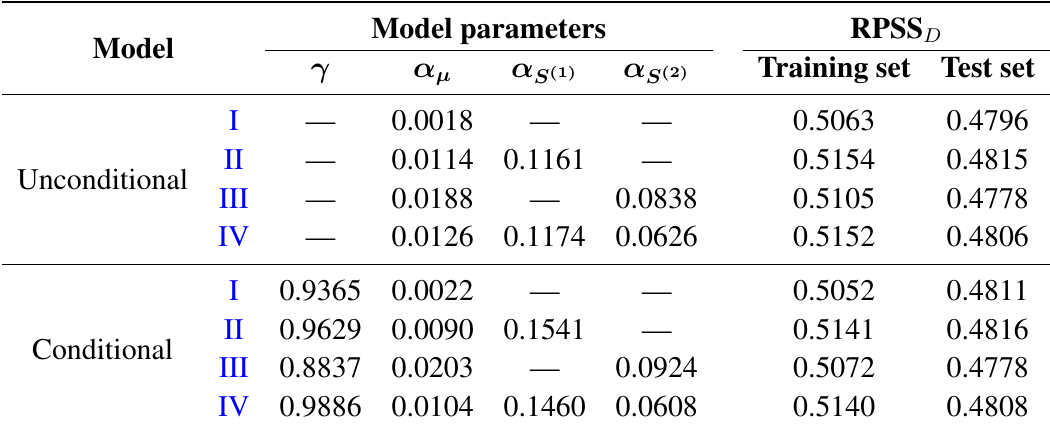
for the different model setups D